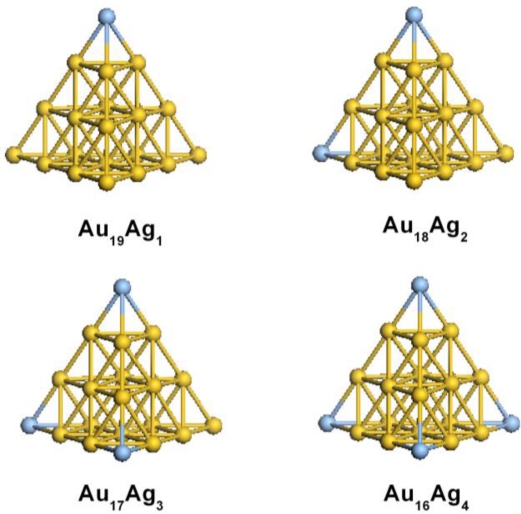
Calculated ground state geometries of Au20−nAgn.